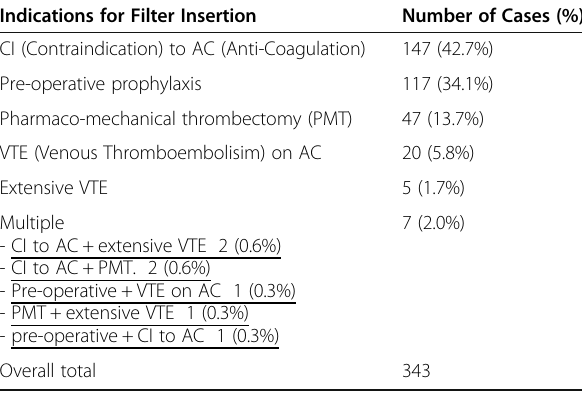
Table 2 Indications for Filter Insertion ( n = 343) Indications for Filter